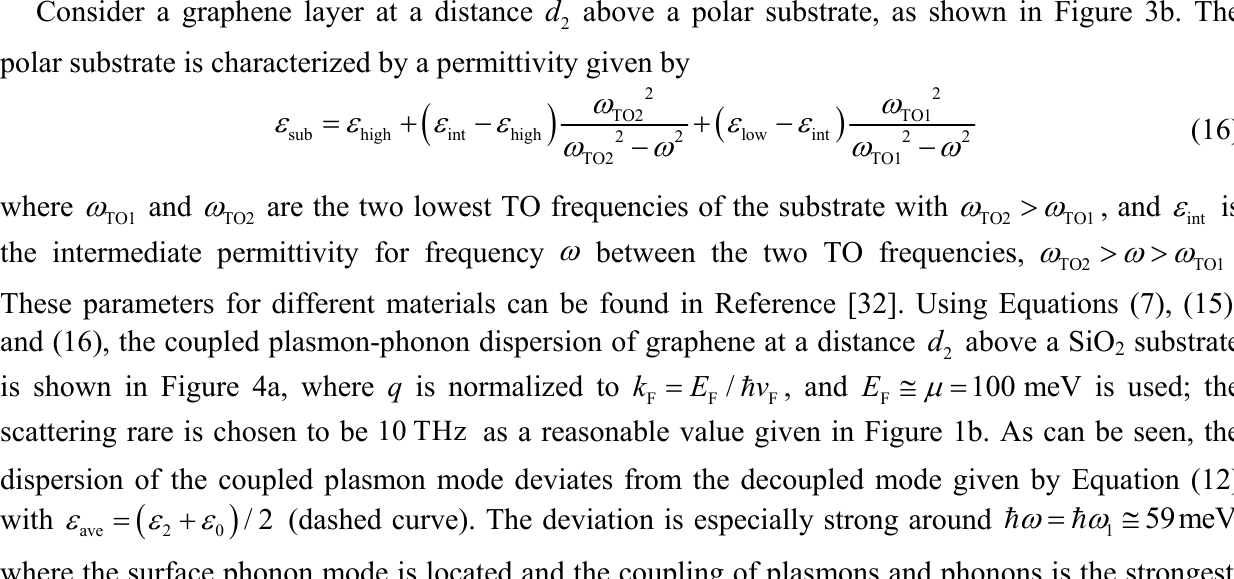
and ( b ) various semi-infinite polar 2